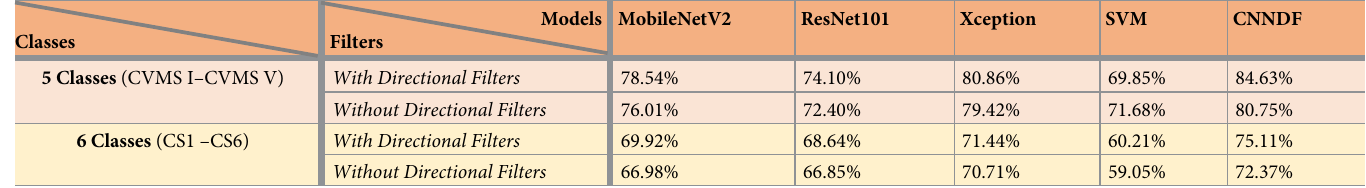
Table 2. The accuracy comparison of the various ML models investigated. Every ML model was tested with and without the directional filters. The results are shown in a table for comparison. Fully connected CNN with the Directional Filters (CNNDF) outperforms every other combination. Classes